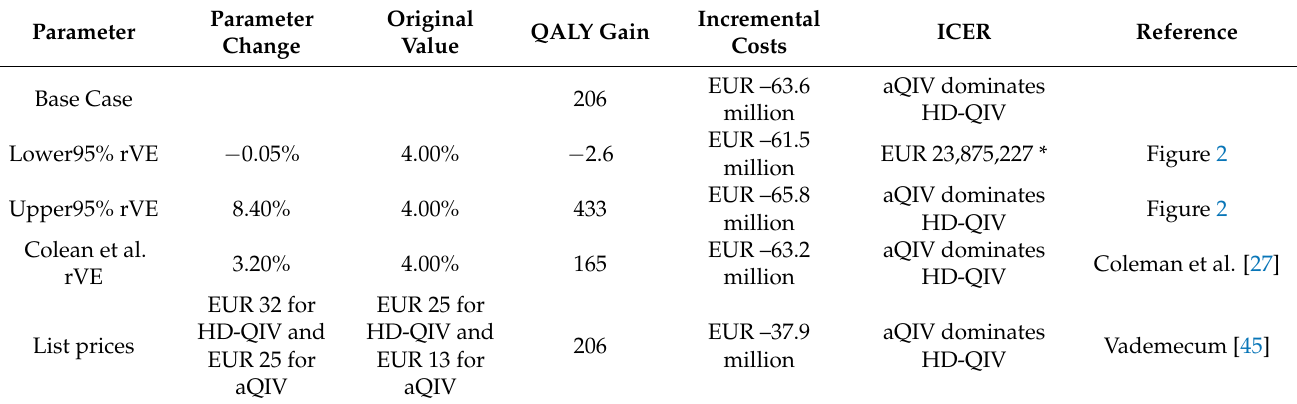
Table 4. Scenario analysis for aQIV compared to HD-QIV.